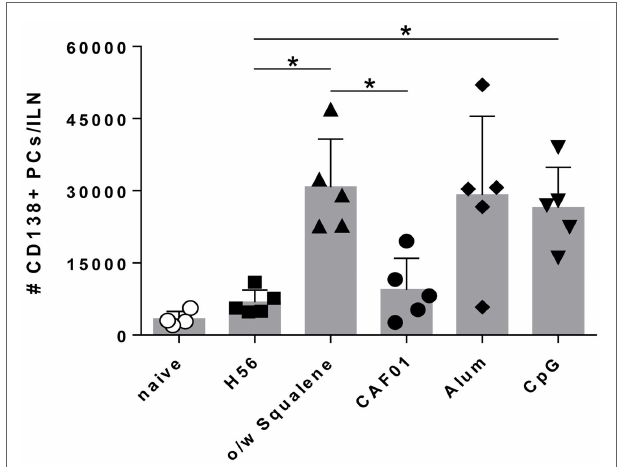
FigUre 4 | Plasma cells generation in draining lymph nodes . C57BL/6 mice were subcutaneously immunized with H56 alone (H56) or combined with different adjuvants (o/w squalene, CAF01, alum, and CpG), and the induction of short-lived plasma cells was analyzed in dLN, 12 days after immunization. Values are reported as number of CD3 − IgD − CD138 + B220 int plasma cells detected in the organ. Bars indicate the mean ± SD of five mice per group; data are representative of two independent experiments. Mann– Whitney test with Bonferroni correction for multiple pairwise comparisons was used for assessing statistical difference between each group immunized with adjuvant and the H56-immunized group. Kruskal–Wallis test, followed by Dunn’s post test for multiple comparisons, was used to assess the statistical difference between groups immunized with different adjuvants (* P ≤ 0.05).